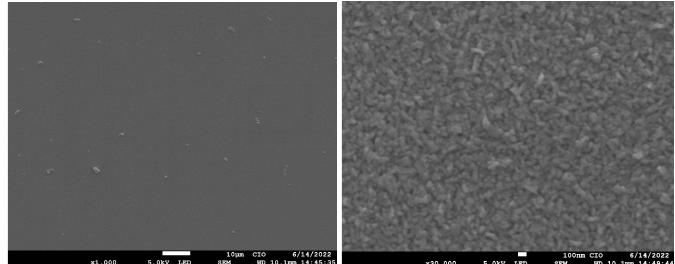
Figure 8. Micrograph SEM of the sample of GaAs (M3).